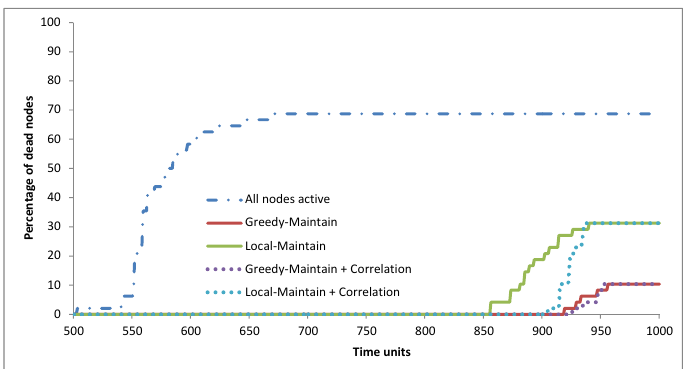
Figure 14. CIT-1’s percentage of dead nodes over time.